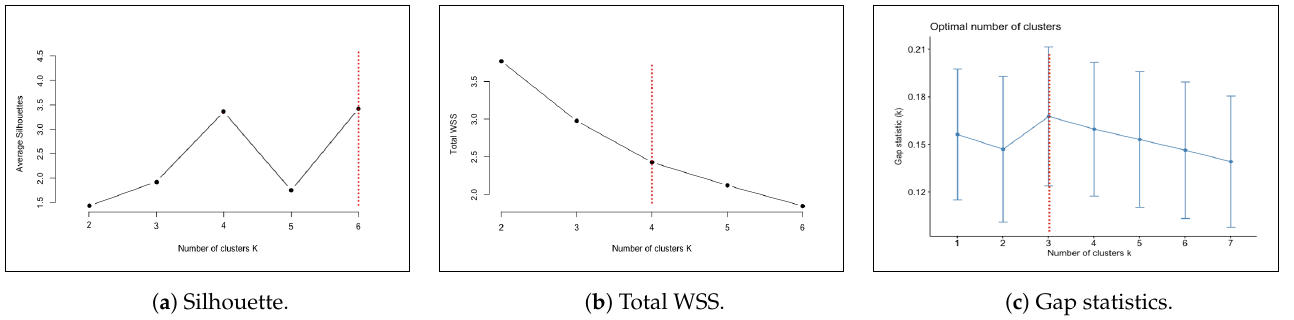
Figure 3. Statistical methods to determine the optimal number of Kmeans